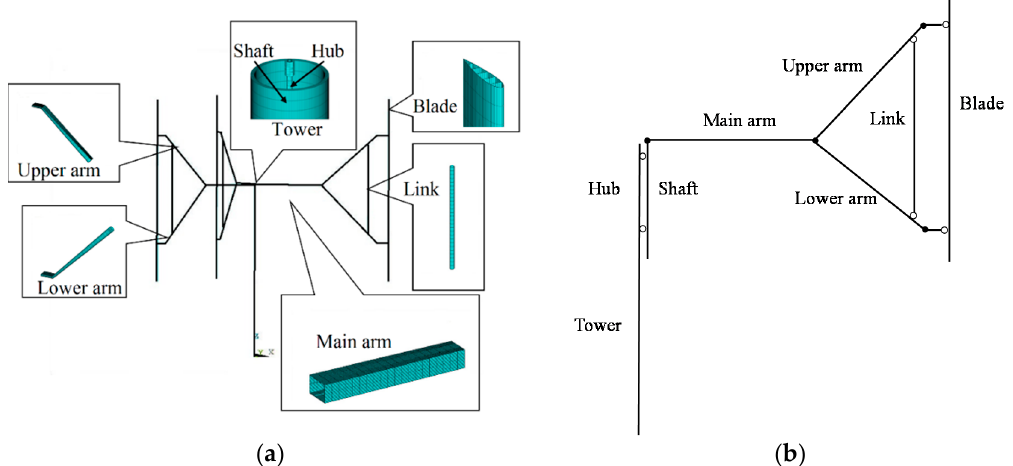
Figure 8. Largest strength index for different azimuth angles.